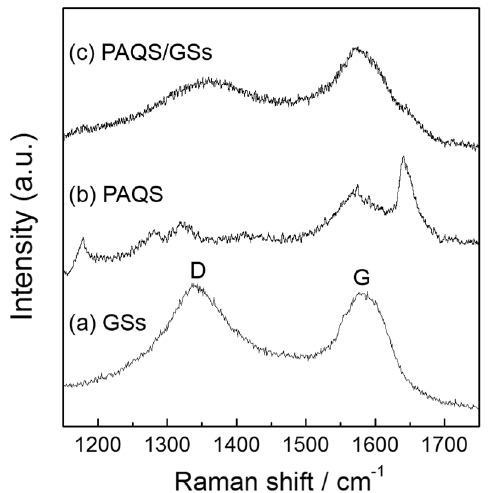
Figure 2. Raman spectra of ( a ) GSs; ( b ) PAQS; and ( c ) PAQS/GSs at an excitation wavelength of 514